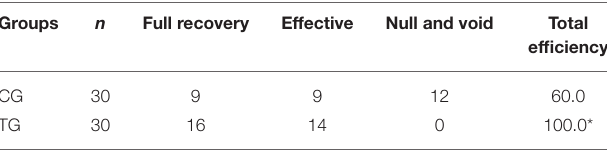
TABLE 2 | Comparison of daily average alcohol consumption before and after treatment.